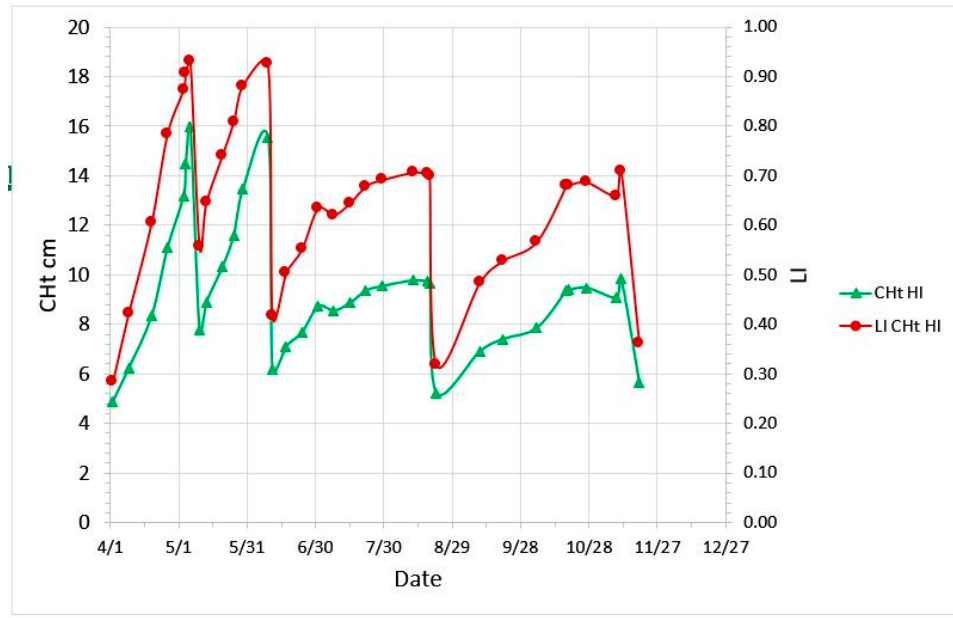
Figure 4. Pasture plate meter compressed height (CHt, cm) and light interception (LI, fraction of ambient PAR) across the grazing season, showing growth and defoliation of the canopy.